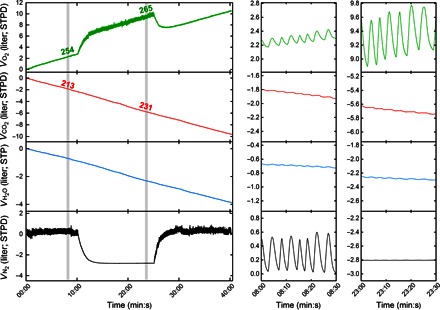
Results from direct integration over time to calculate cumulative gas exchange during an O2 wash-in and wash-out experiment.Left panel shows the data over the whole time period, and expanded time scales are shown in the two panels to the right. The slopes give the rate of gas uptake (negative in the case of CO2 and H2O). Values are given in ml/min above the shaded regions. Right panels show the scaling of the ordinate axes that have been kept the same to illustrate the relative contributions of each gas species to tidal volume. Note that, apart from the periods of washing N2 out of or into the lung, the overall slope of the N2 volume plot is close to zero, illustrating the precision of the measurements. STPD, standard temperature and pressure, dry.